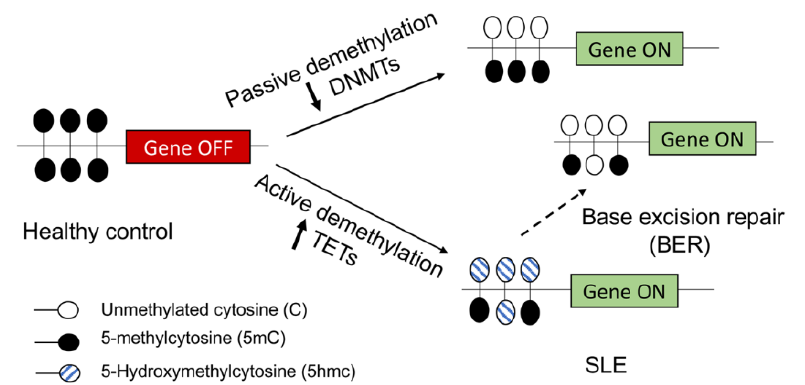
Figure 1. DNA demethylation mechanism in SLE. In healthy controls, the specific lupus-related gene is turned off by the methylation of cytosine (5-mC) in the CpG dinucleotide in the gene promoter. In SLE, the lupus-related gene is turned on by the demethylation of the gene promoter. In the passive DNA demethylation pathway, due to reduced DNMTs expression and/or activity, the 5-mC in the gene promotor is passively diluted following DNA replication. In the active DNA demethylation pathway, 5-mC is actively oxidized into 5-Hydroxymethylcytosine (5hmc), which can be further oxidized into 5-formylcytosine and 5-carboxylcytosine by TETs, and then repaired into unmethylated cytosine (C) through the base excision repair (BER) process.